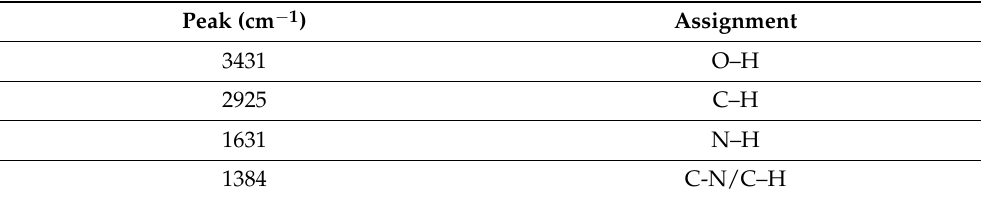
Table 1. Functional groups present in the FTIR spectrum biosynthesized Ag